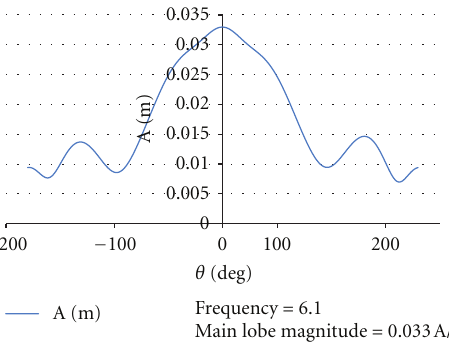
Figure 14: H-field pattern.